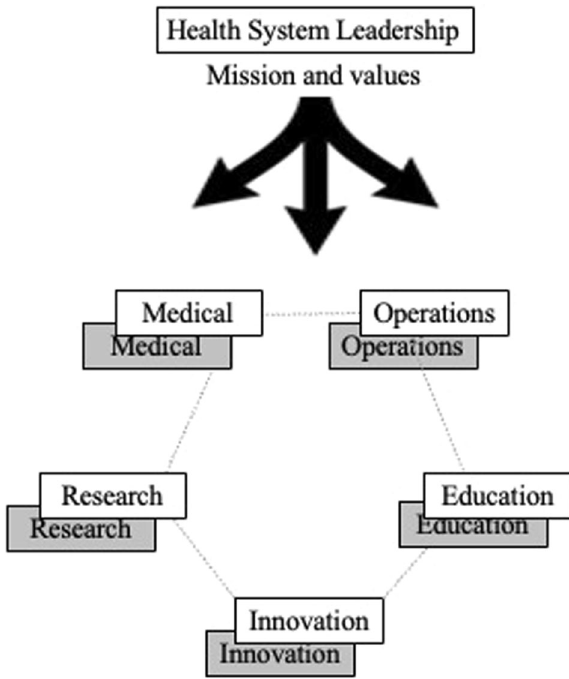
Fig. 2 Digital health within academic medical centers. Organiza- tional schema whereby traditional (white boxes) and digital health (gray boxes) components of the organization are delineated but work closely together toward a common